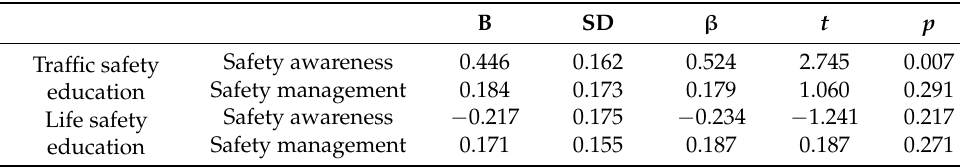
Table 7. Factor of immersion in safety education using